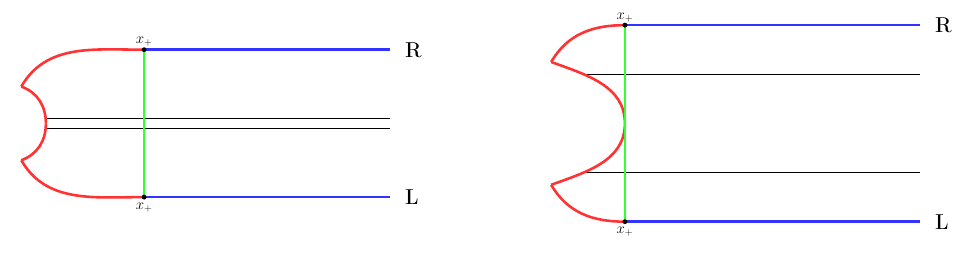
(cid:24) + (cid:24) I . On the left side, we (cid:20) (cid:20)